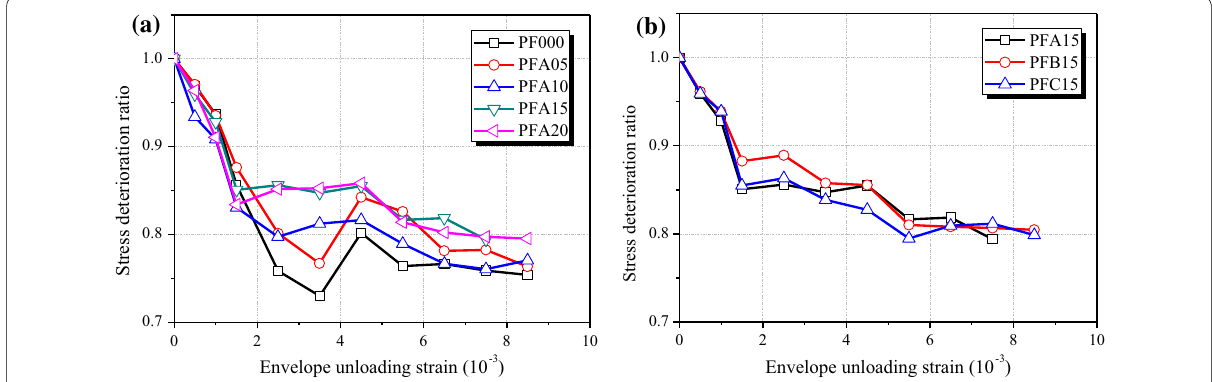
Fig. 9 Relation between stress deterioration ratio and envelope unloading strain of concrete. a Effect of fiber volume fraction. b Effect of fiber aspect